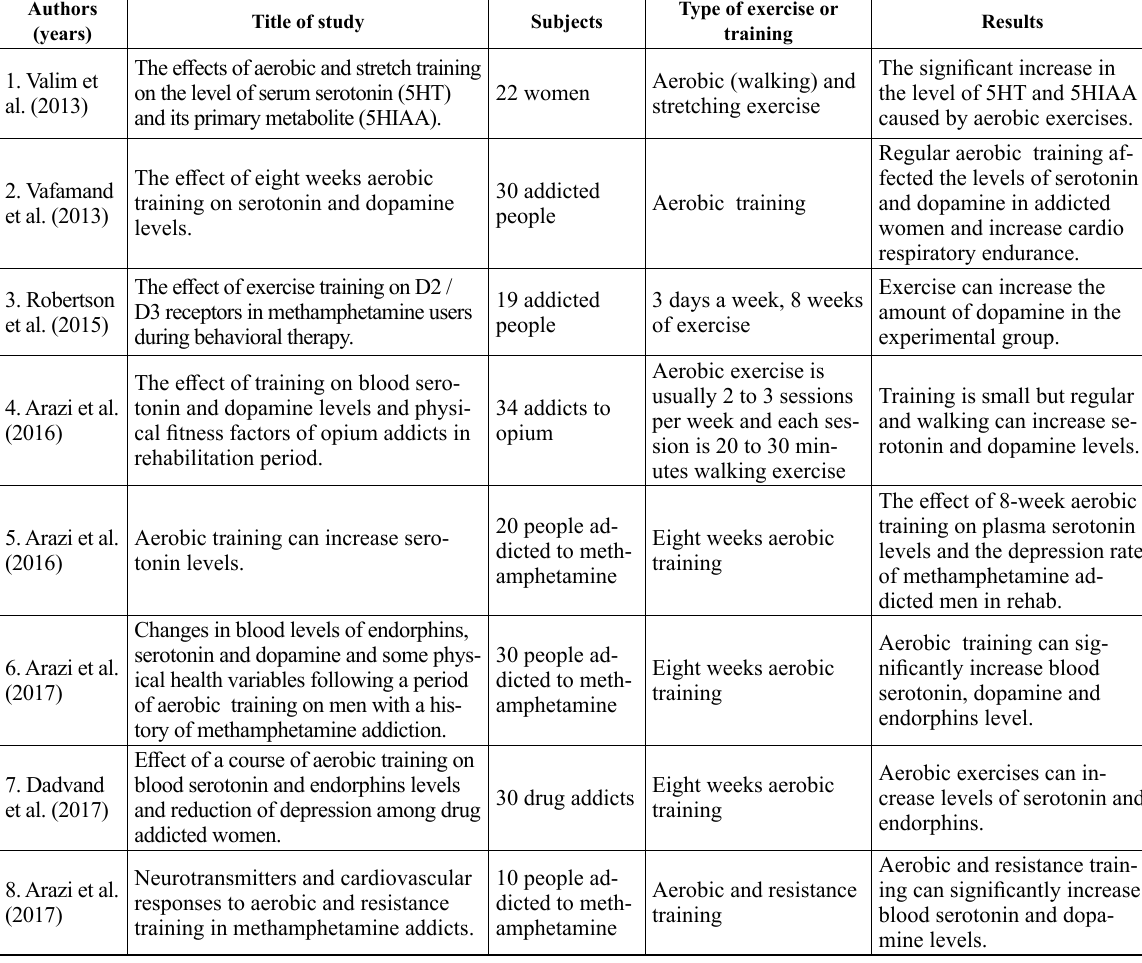
Table 2. Summary of human studies on the effects of various training on neurotransmitter and addiction related factors Authors (years)